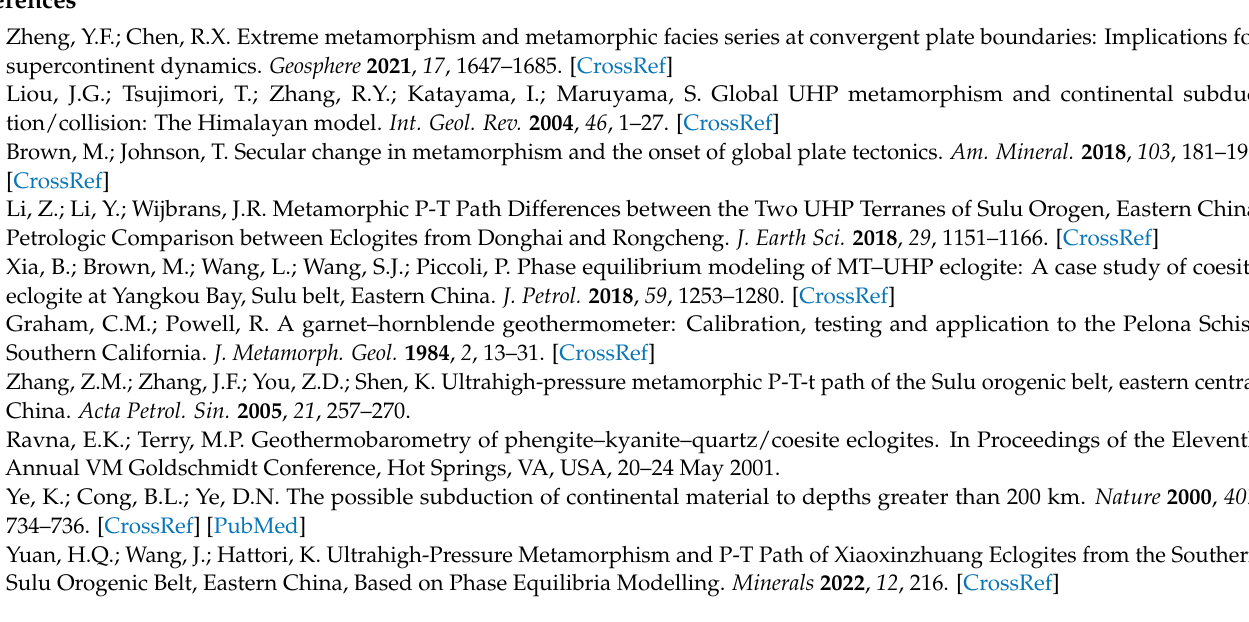
Figure 7; Table S1: Trace element contents (ppm) of eclogites from the Guanshan and Yangkou area. Table S2: Representative microprobe analyses for sample G-11 from the Guanshan eclogites. Table S3: Representative microprobe analyses for sample Y-32 from the Yangkou